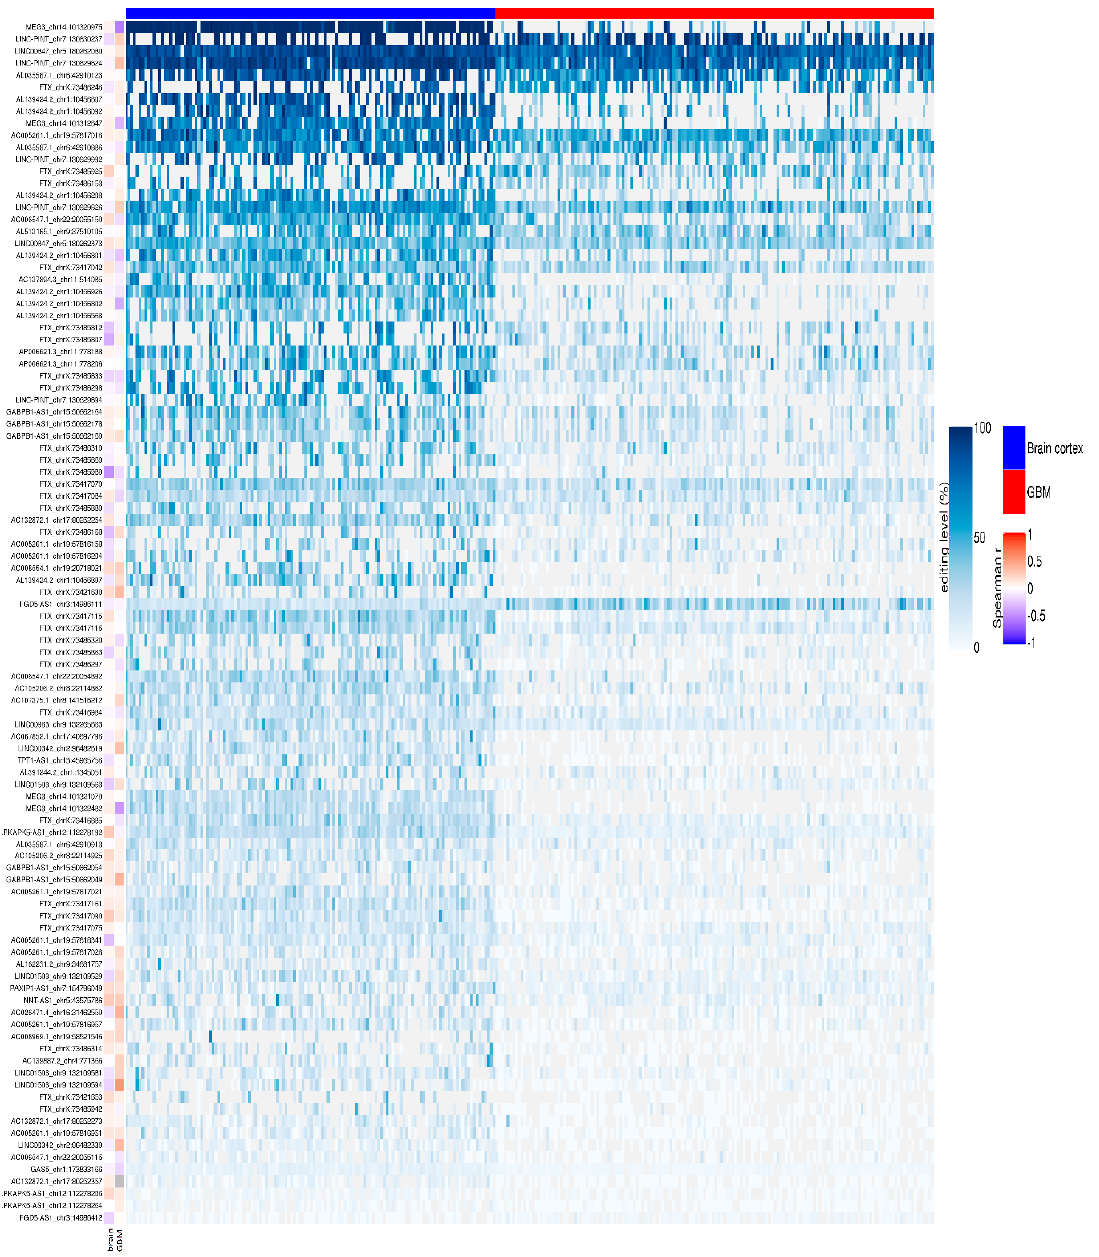
Figure 4. Editing levels at lncRNA sites. Heatmap with row clustering (dendrogram not shown) of editing levels (%) at the selected top 100 most relevant significantly differentially edited sites in glioblastoma compared to brain cortex. Each column represents one of the 156 de novo GBMs (red) and 132 brain cortex (blue) samples. In the vertical annotation bars on the left, for each editing site, the Spearman’s correlation coefficient of the editing level (%) and the gene expression level (TPM) is reported as calculated respectively by REDItools and StringTie.